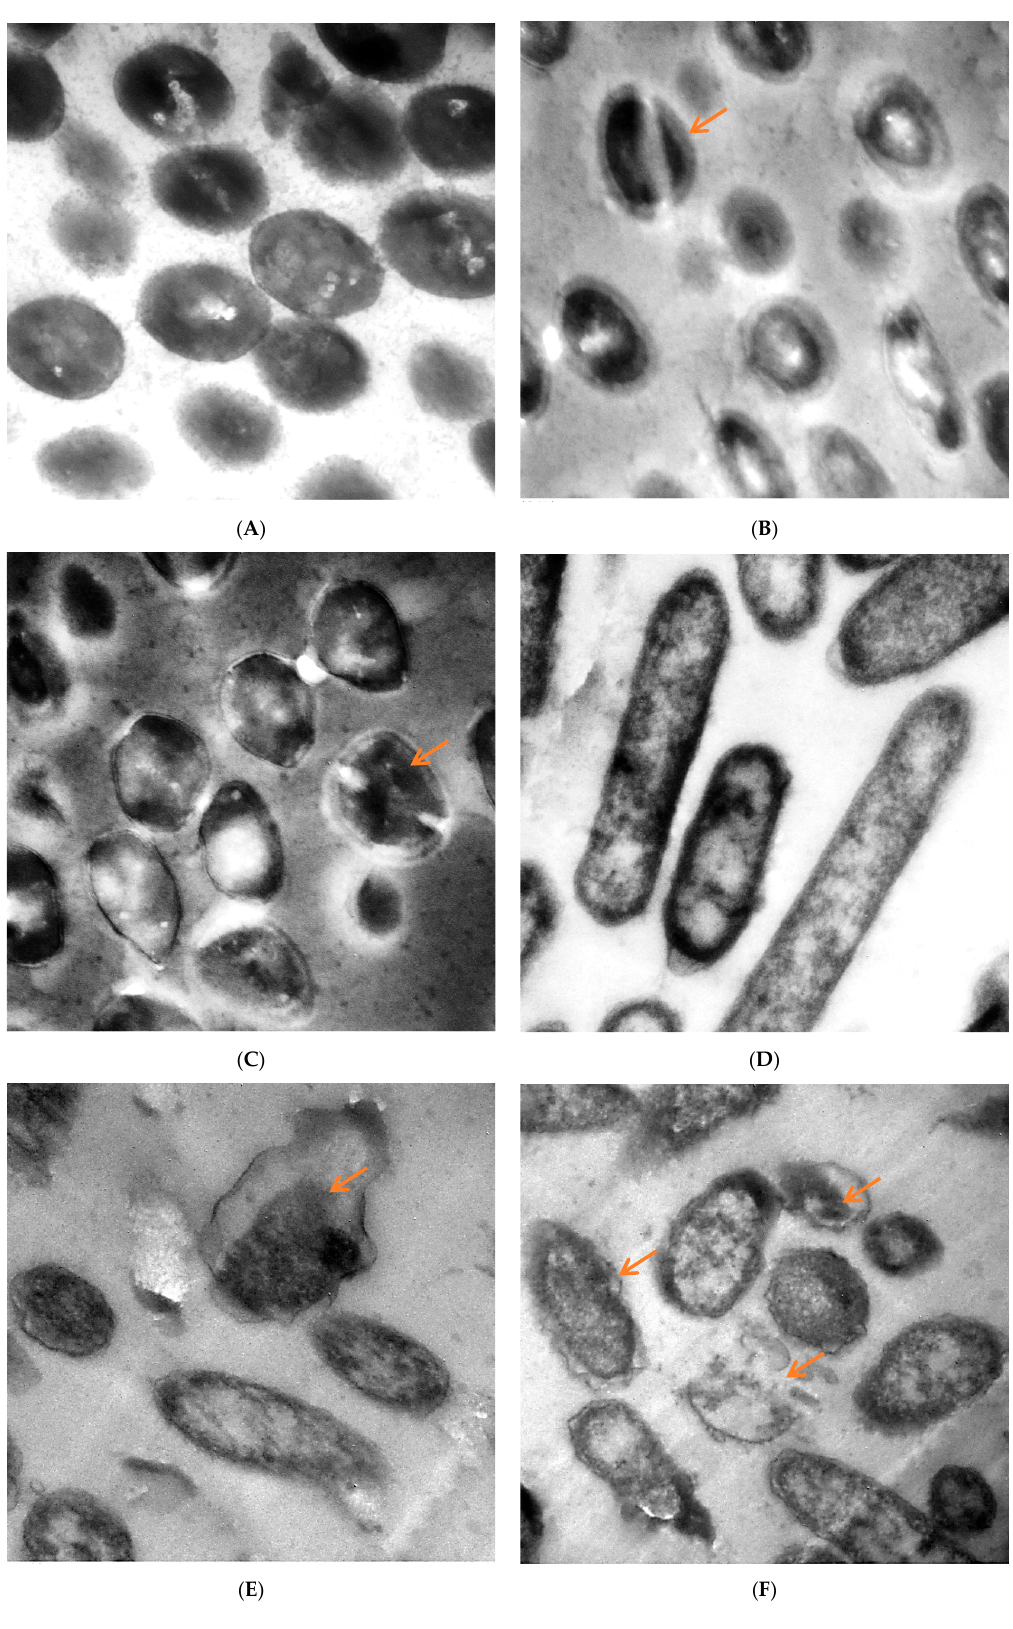
Figure 6. TEM micrographs of ( A ) untreated S. aureus , ( B ) S. aureus treated at 62.50 µ g/mL and ( C ) at 100 µ g/mL, ( D ) untreated P. aeruginosa , ( E ) P. aeruginosa treated with M. pulegium extract at 15.62 µ g/mL and ( F ) at 30 µ g/mL. Scale Bar = 100 nm, 5000 ×